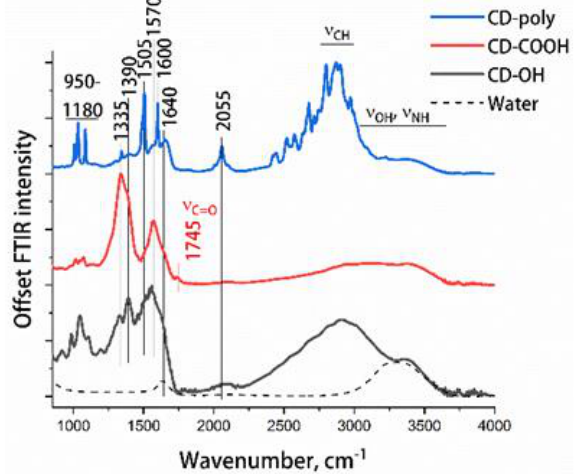
Figure 2. IR absorption spectra of water and powders of synthesized CDs. The IR absorption spectra of three CD samples contain a similar set of bands that differ in relative absorption intensity. In the region of 3000–3700 cm − 1 , there is a wide band caused by stretching vibrations of the surface hydroxyl and amino groups and OH groups of water molecules adsorbed on the surface of the samples. The relative intensity of this band for CD-poly and CD-COOH is significantly lower than for CD-OH. In the region of 2800–3000 cm − 1 there are bands of stretching vibrations of CH x groups. In the region of 2055 cm − 1 , there is a band that presumably belongs to overtones/combinations of various vibrations in CDs [36]. The band at 1745 cm − 1 in the spectrum of CD-COOH corresponds to the stretching vibrations of C=O bonds of surface carboxyl groups. The weak relative intensity of this band is due to the fact that the COOH groups belong exclusively to the surface of this CD, while most other vibrational bands are due to the vibrations of the groups that are also in the CD’s core. This situation is typical for CDs with a size of about 100 nm and does not manifest itself, for example, for nanodiamonds with a carboxylated surface: in them, the diamond core is not active, and the relative intensity of the vibration bands of all surface groups is much higher